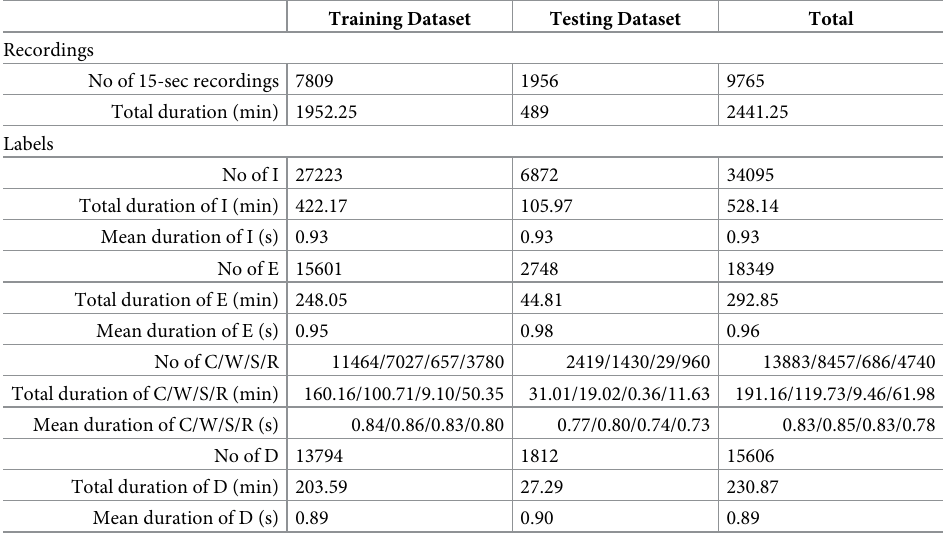
Table 3. Statistics of the datasets and labels of the HF_Lung_V1